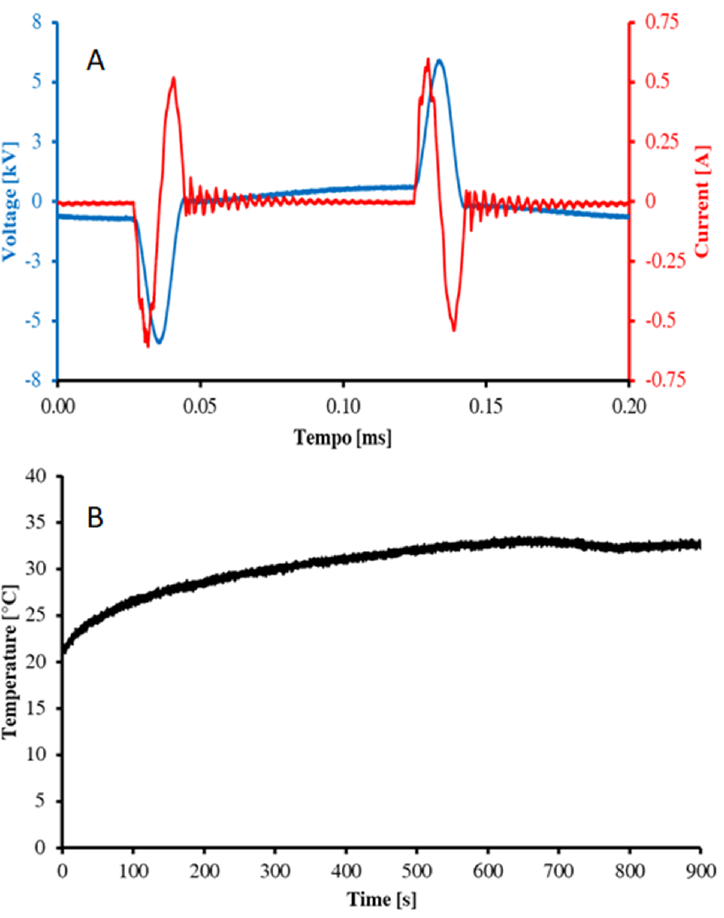
Figure 3. Voltage (blue) and current (red) waveforms ( A ) and gas temperature measurements during 900 s of discharge ( B ).